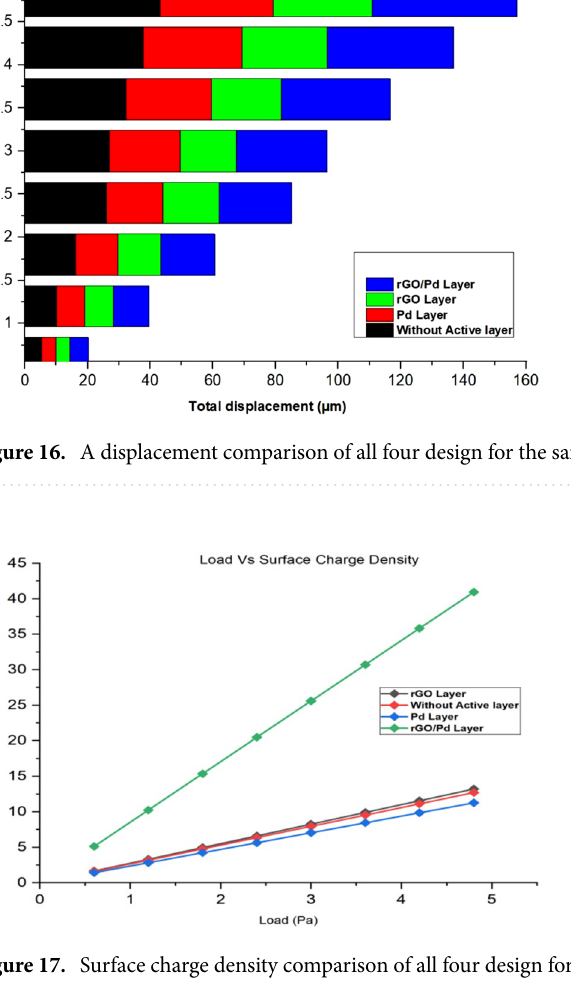
Figure 17. Surface charge density comparison of all four design for the same applied